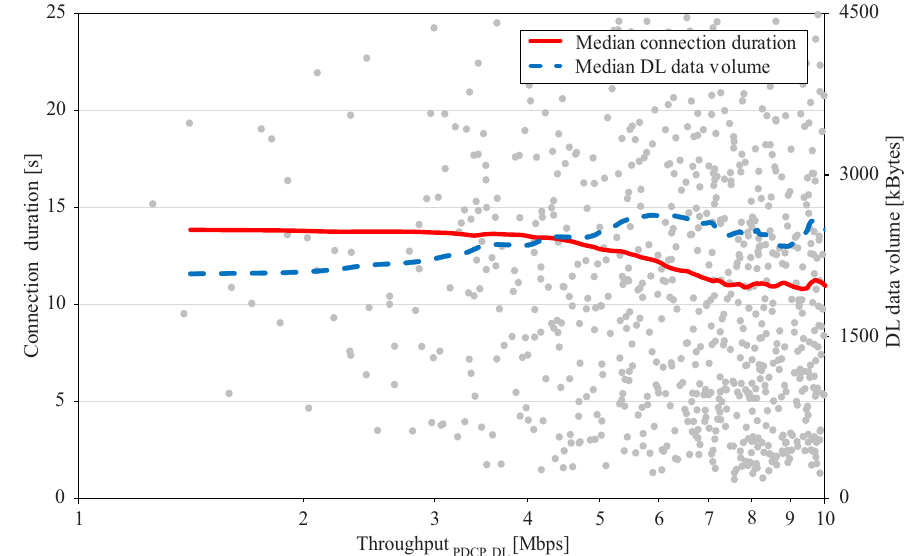
Figure 2. Quality of Service (QoS) and traffic indicators for full-buffer data